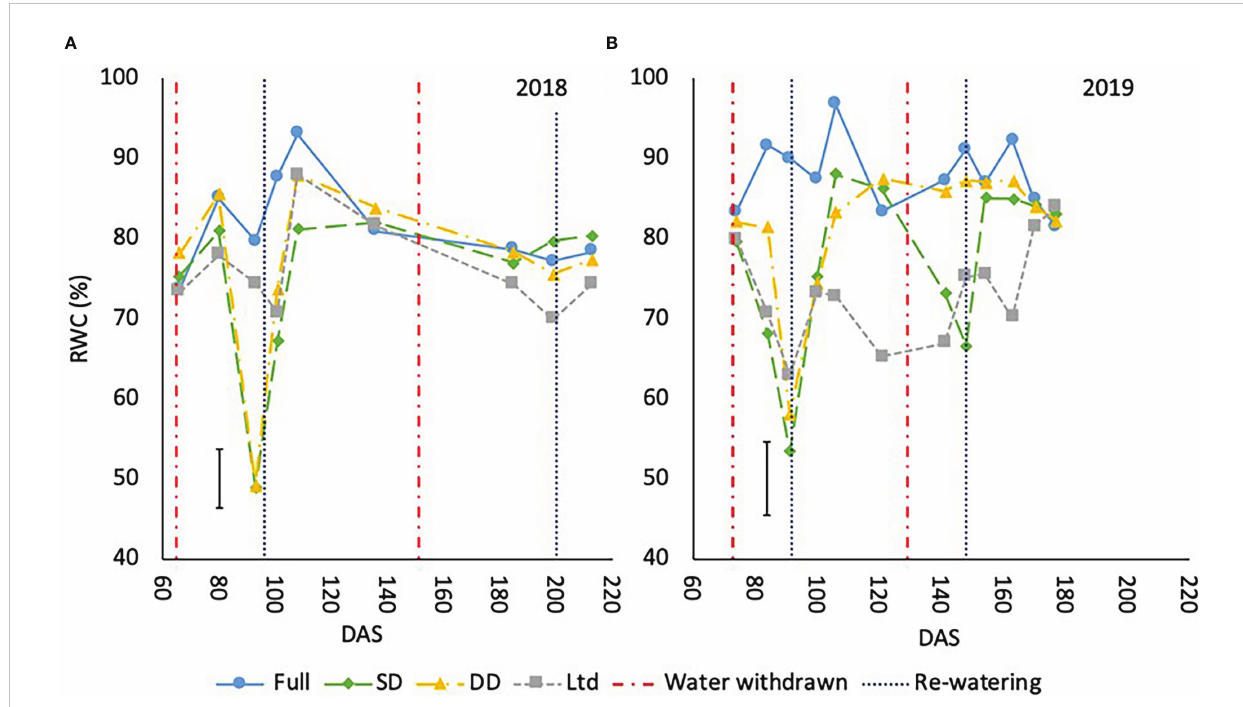
FIGURE 5 The relative water content (RWC) (%) of sugar beet grown under four different irrigation regimes in 2018 (A) (LSD=7.34 P<0.001) and 2019 (B) (LSD=9.16 P<0.001). Error bars shows irrigation x time LSD. Irrigation regimes were a fully irrigated (Full), a continually water limited kept at approx. 50% fi eld capacity (Ltd), a single drought (SD) (2018 65-96 DAS and 2019 73 -92 DAS) and a double drought (DD) which was exposed to the single drought treatment plus an additional drought (2018 151-200 DAS and 2019 118-182